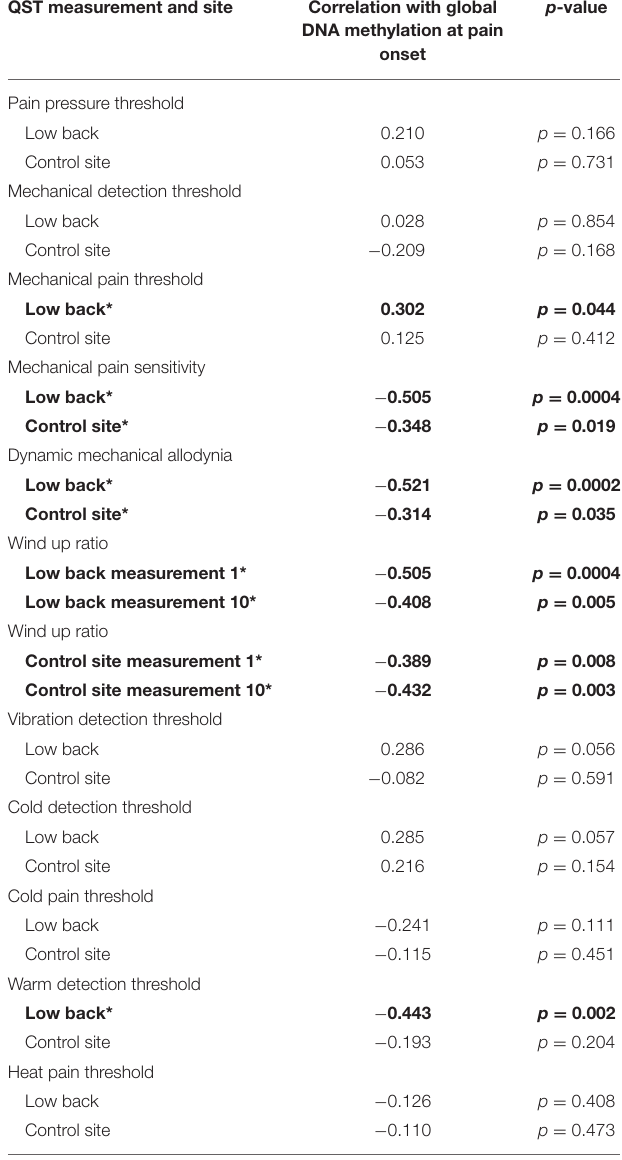
TABLE 7 | Correlation of quantitative sensory testing (QST) at the site of pain and the control site with methylation. QST measurement and